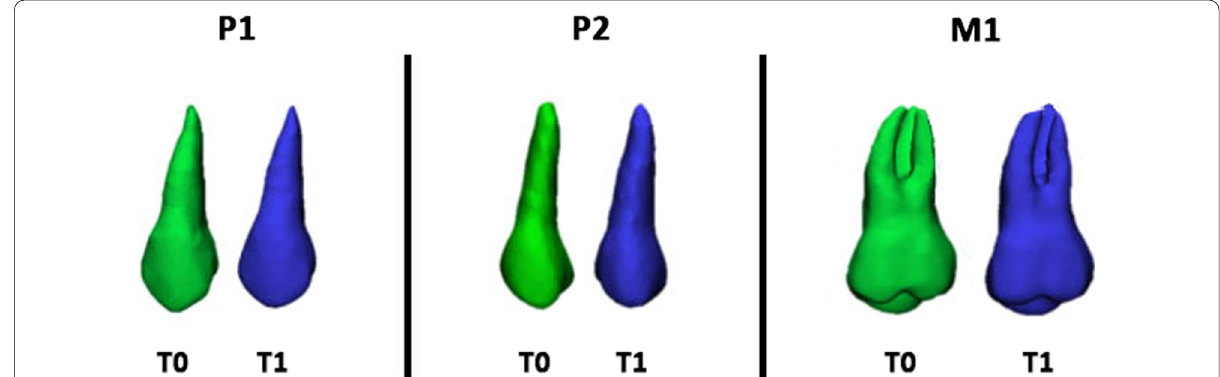
Fig. 1 Color‑coded labeling of T0 and T1 tooth models: maxillary first premolar (P1), maxillary second premolar (P2), and maxillary first molar (M1)